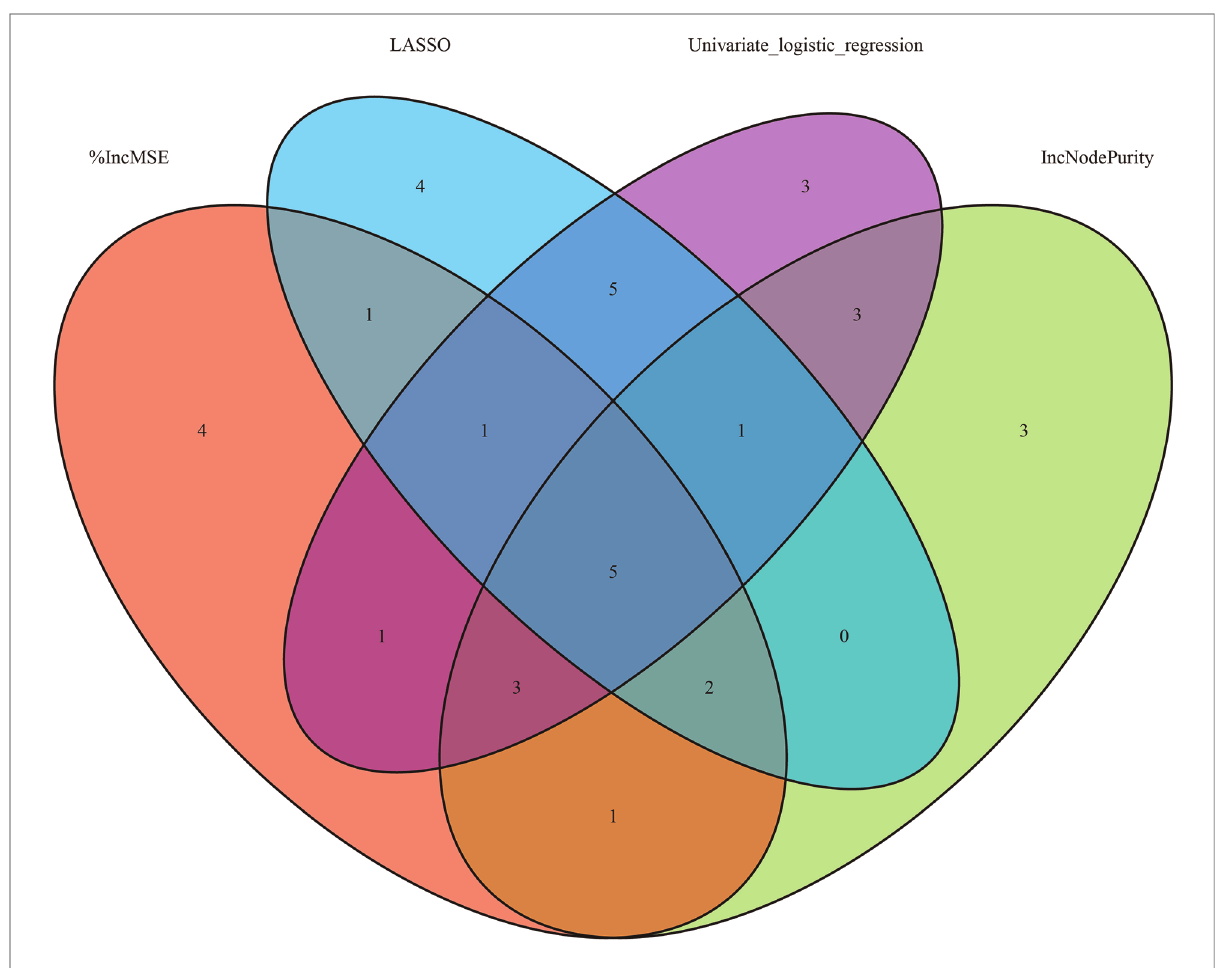
FIGURE 5 4 methods venn